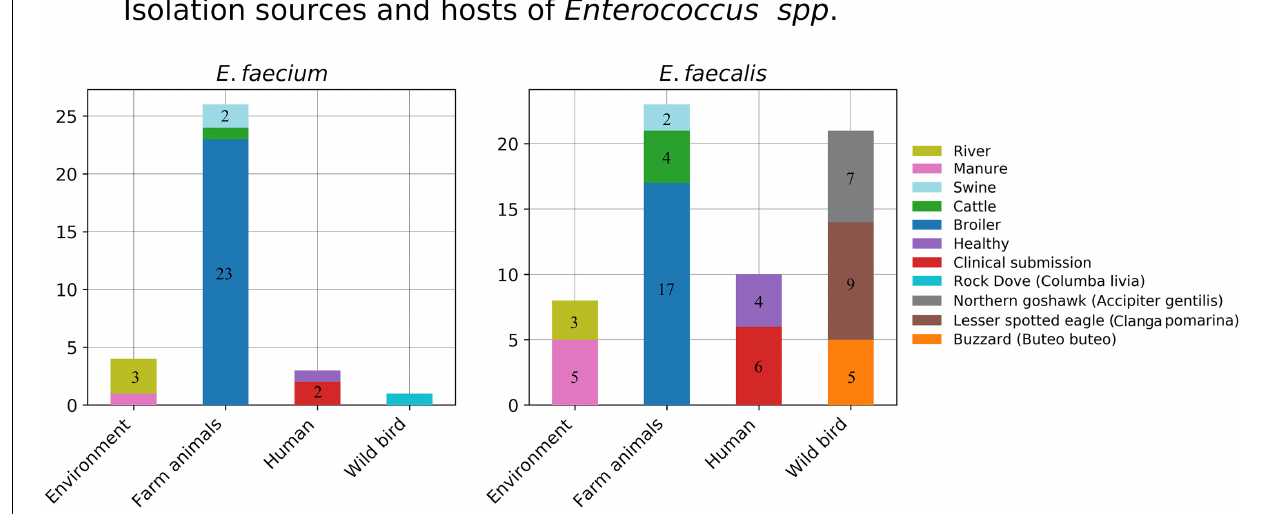
FIGURE 1 | Isolation sources and hosts of the collected Enterococcus